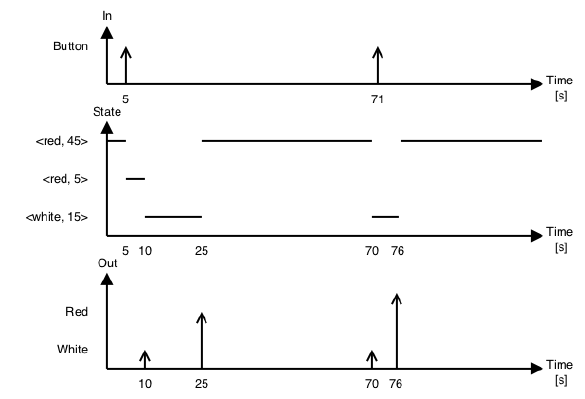
Figure 2: Trajectories of traffic light with input without uncertainty intervals